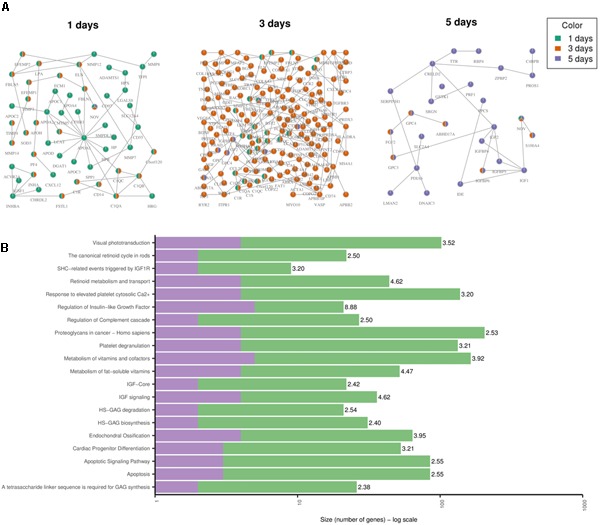
Toxicity Modules. (A) Toxicity modules were identified using the HotNet2 propagation algorithm for DOX drug treatments after 1, 3, and 5 days. Each node corresponds to a protein coding gene (the nodes are named using their HGNC symbol) and each edge is an interaction as defined by the PPI network of ConsensusPathDB (see Methods). The colors of the nodes indicate the time point. Nodes that are colored in green only are present in the “1 day” module only. In the same way for orange and purple. Nodes that are colored in two colors are present in the two corresponding modules. Nodes that are colored in three colors are present in all modules. (B) The top 20 over-represented pathways for the “5 days” module, based on the ORA of the genes in the module with ConsensusPathDB (see Methods). The purple color represents the overlap of genes from the pathway and the module. The green are the rest of the genes from the pathway (that are not in the module). The number next to each bar displays the significance of the over-representation [–log10(Q-value) of the corresponding pathway].